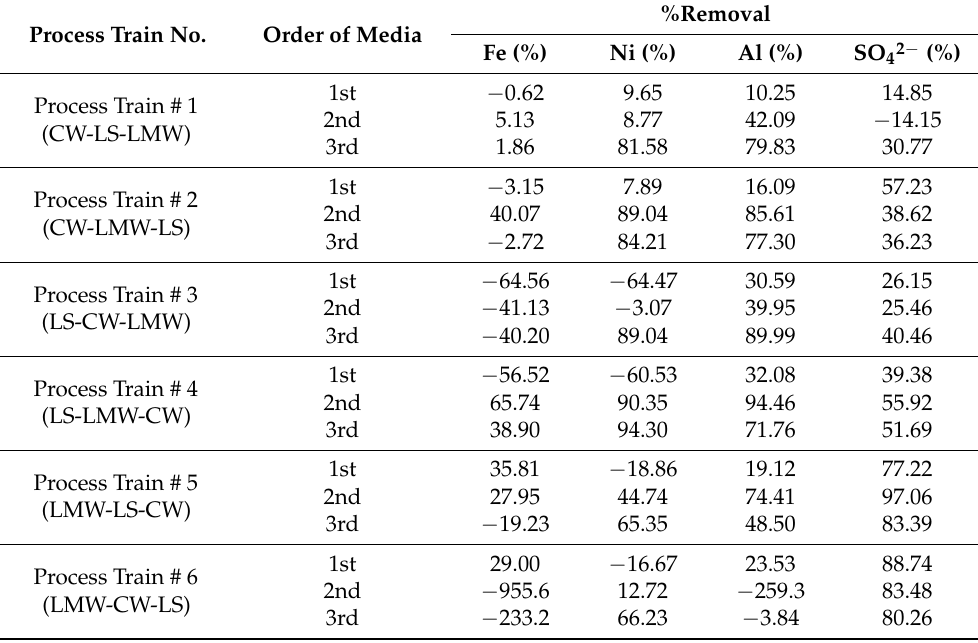
Table 7. % metal removal of the process trains.